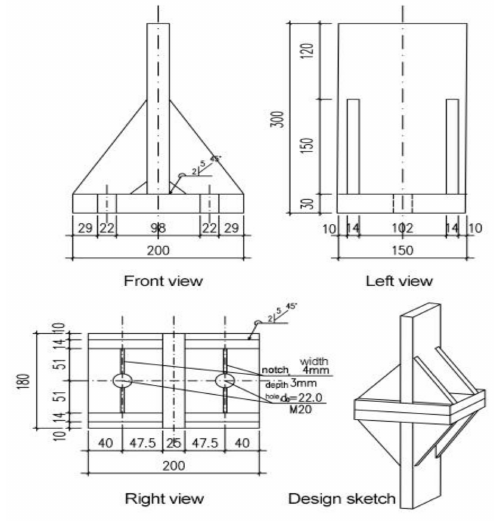
Figure 2. T-type